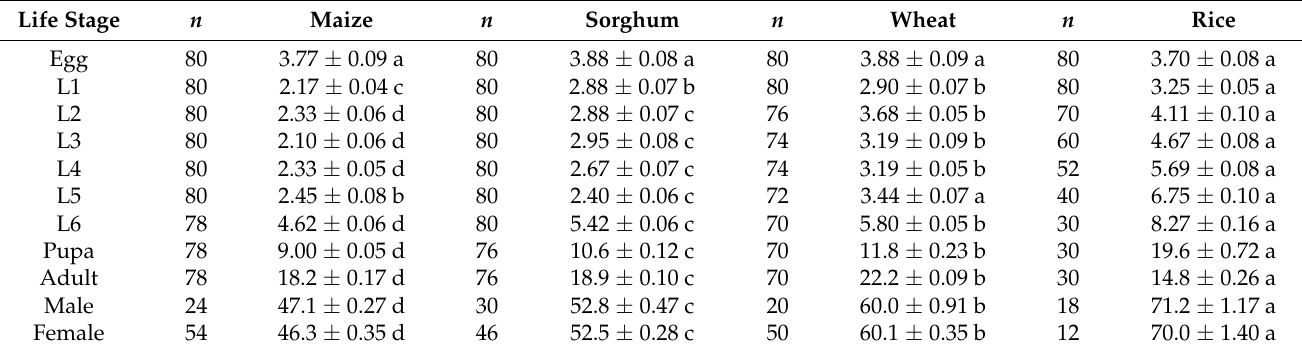
n = number of individuals; means sharing similar letters within a row are not significantly different at p > 0.05; L1–L6 indicate larval instars. Table 2. Comparison of reproductive and life table parameters (mean ± SE) of S. frugiperda fed on four host plants. Parameters